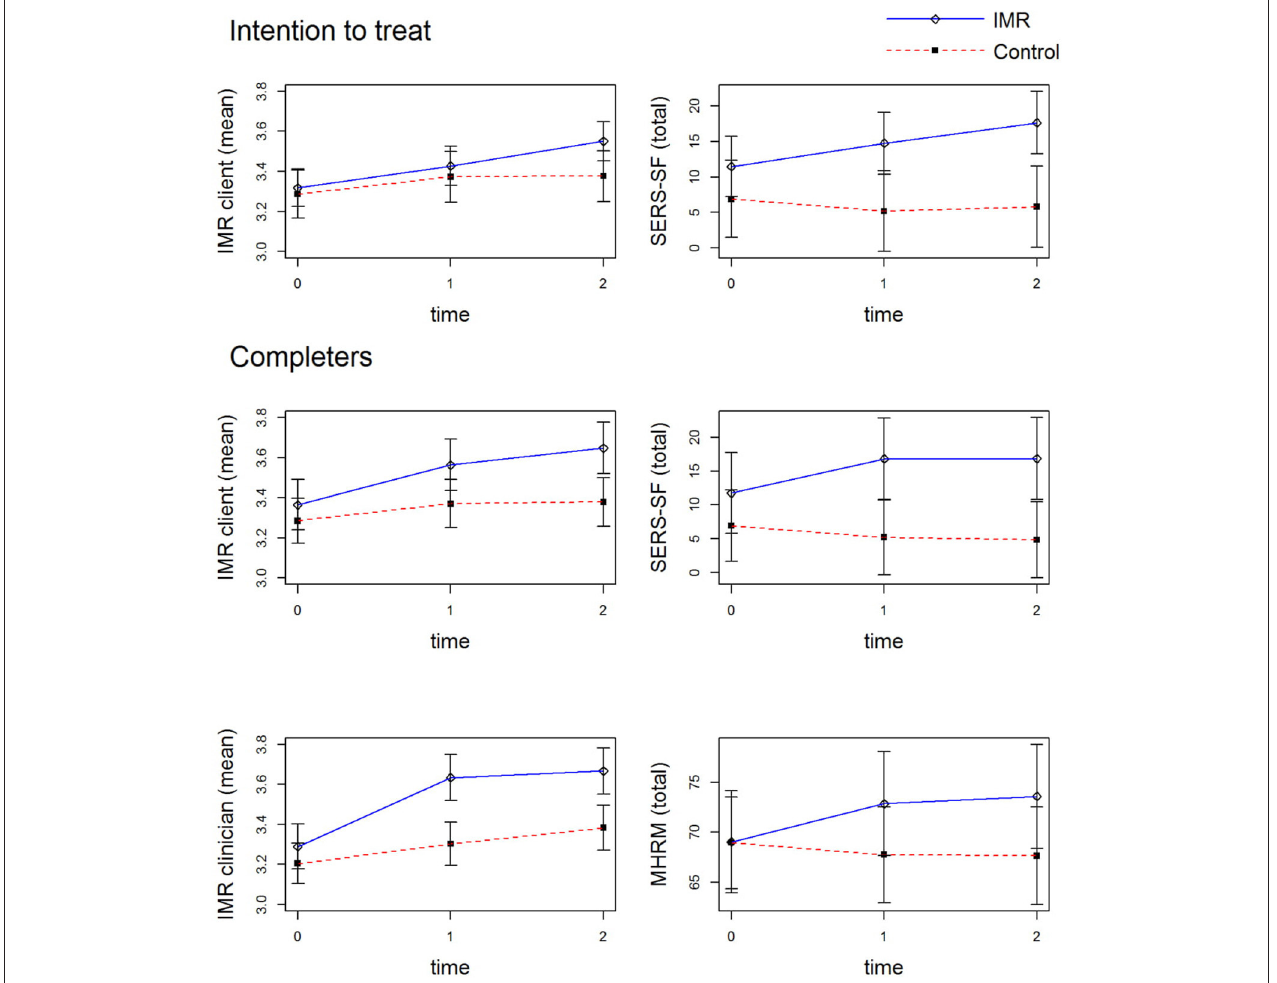
FIGURE 3 | Significant Outcomes at 18 Months. 0 = baseline measurement, 1 = 12-months measurement, 2 = 18-months measurement. IMR client, client version of the Illness Management and Recovery scale; IMR clinician, clinician version of the Illness Management and Recovery scale; SERS-SF, Self Esteem Rating Scale-Short Form; MHRM, Mental Health Recovery